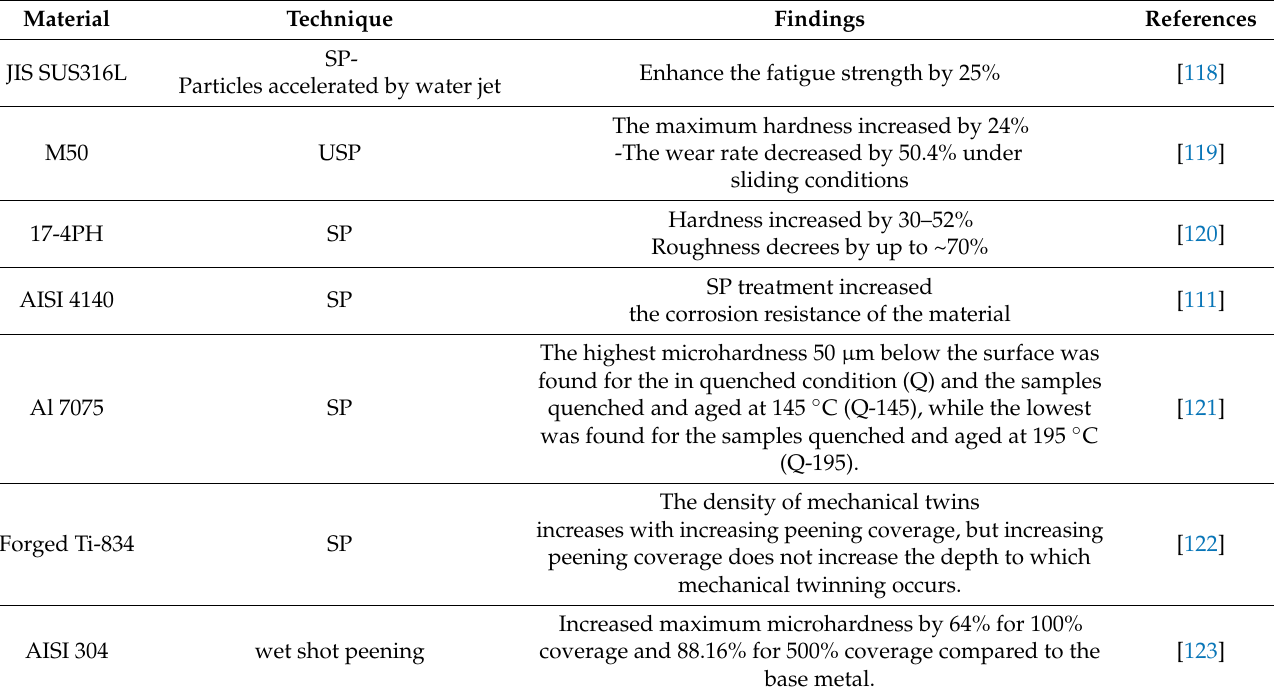
Table 2. Effects of SP on materials’ properties and